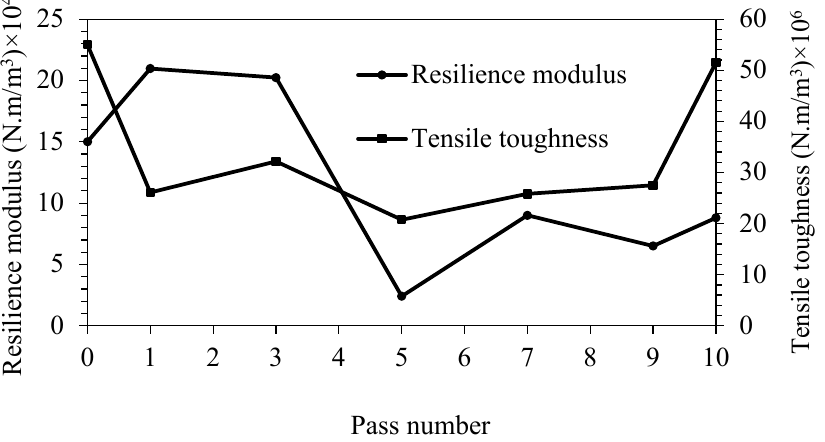
Figure 9. Comparison of resilience modulus and tensile toughness values of modified-CSP samples for each